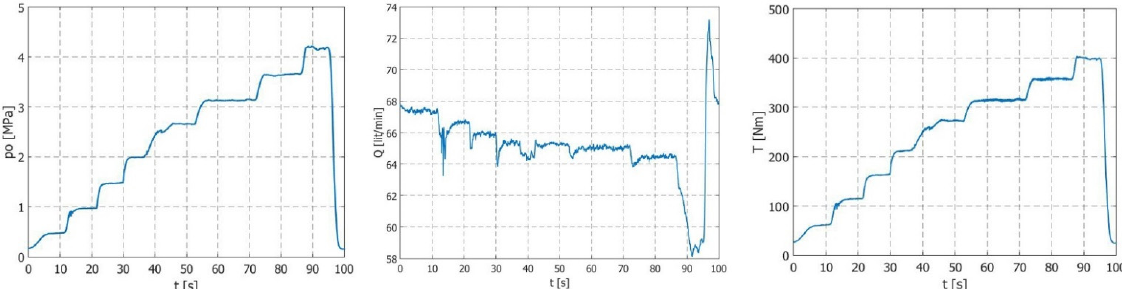
Figure 8. Diagram of dependence of the output pressure, working fluid’s flow rate, and torque of the pump shaft over time in the IR4 operating mode.